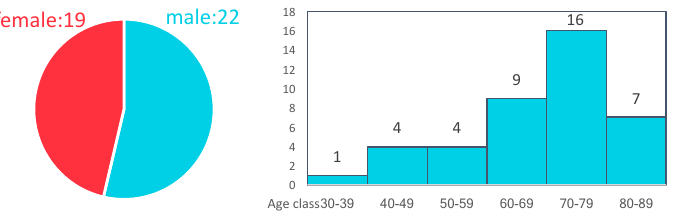
Figure 15. Demographic characteristics of the patients.